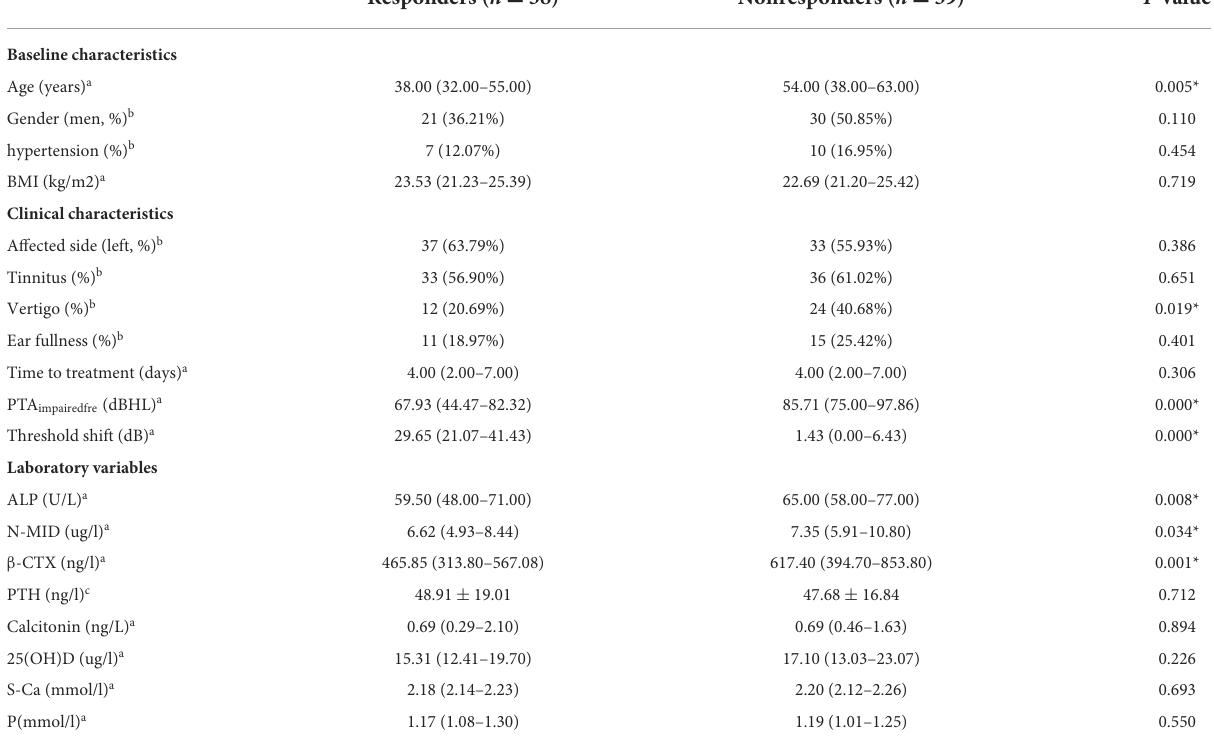
TABLE 1 Characteristics of data in SSNHL